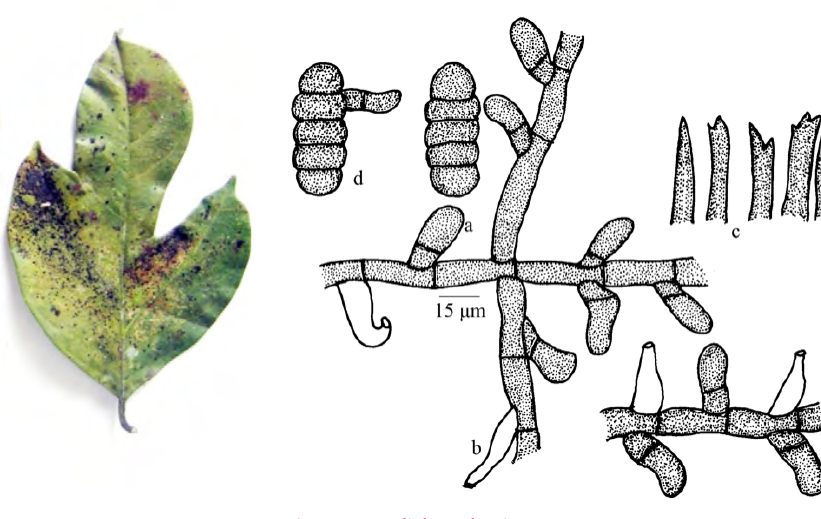
Figure 48. Meliola atalantiae a - Appressorium; b - Phialide; c - Apical portion of mycelial setae; d -